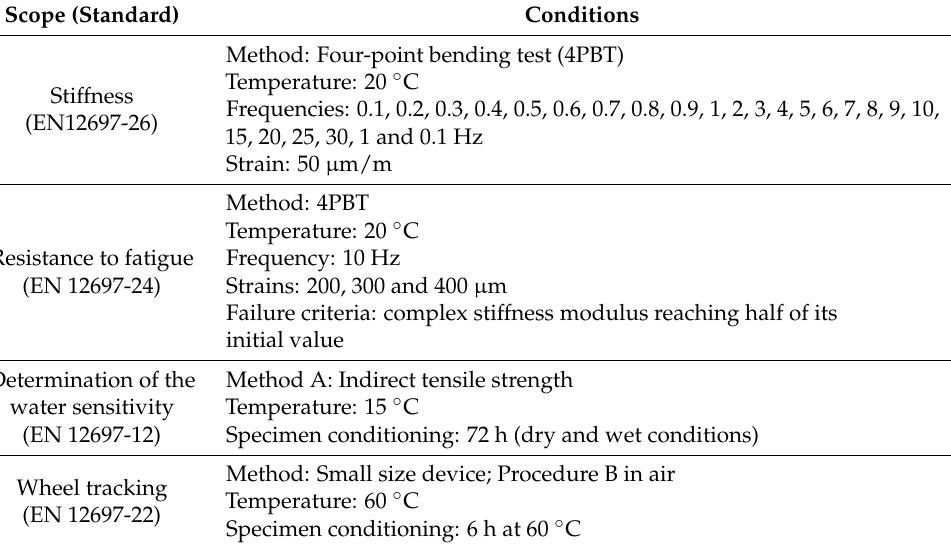
Table 1. Mechanical tests.